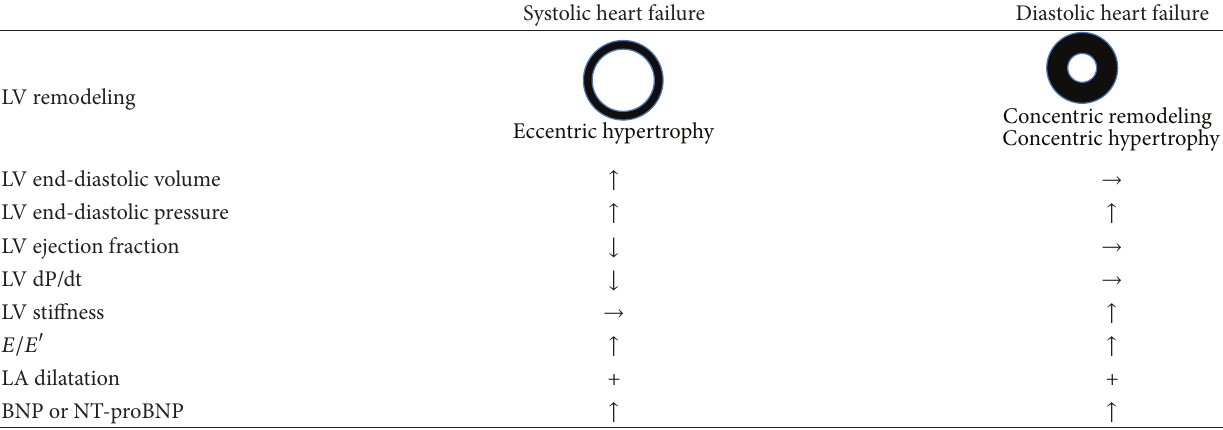
Table 1: Comparison of systolic and diastolic heart